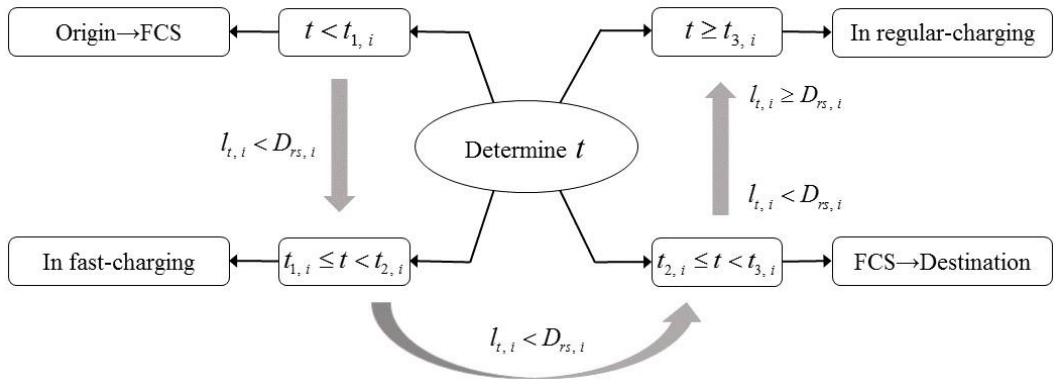
Figure 5. The decision diagram for fast-charging EVs.